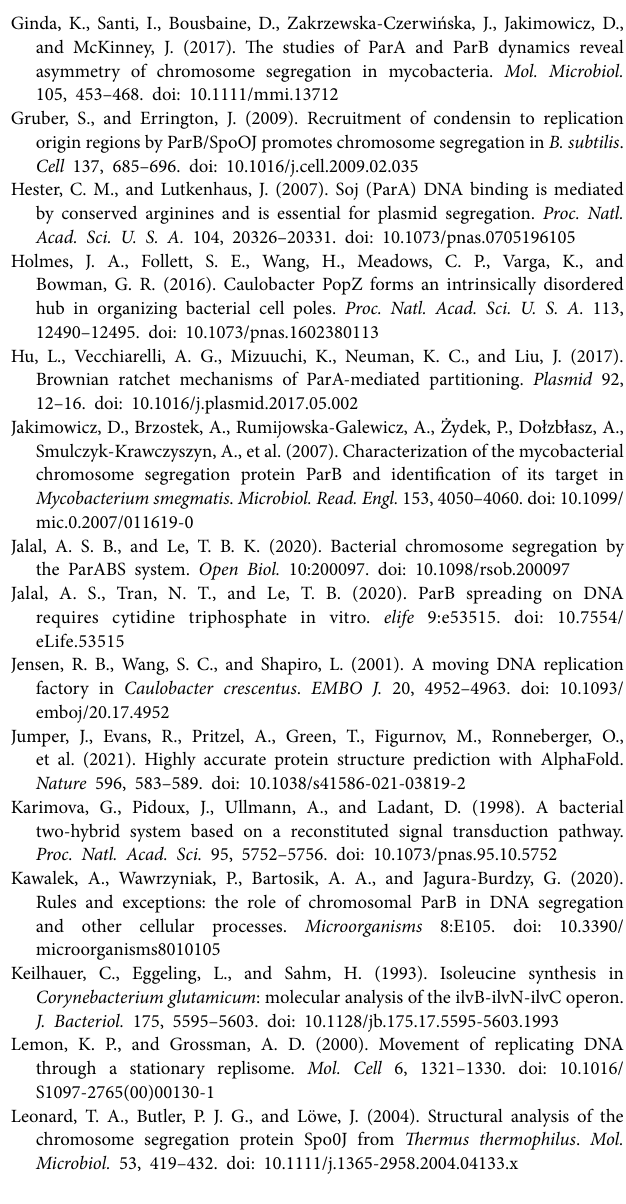
(ParACg) or heterologous parA from M. smegmatis (ParAMs), two clones of each strain were analysed. C. glutamicum Δ parA strain was used as the control ( Δ parA ). Cultures at logarithmic phase were induced with 0.05 mM IPTG for 2 h. Cells were lysed by sonication and 100 μ g of proteins were subjected to 10% SDS-PAGE electrophoresis and then transferred on nitrocellulose blotting membrane. The membrane was incubated with rabbit serum containing anti- ParA Ms antibody. As secondary antibody anti-rabbit IgG conjugated with alkaline phosphatase was used. Prestained protein ladder Thermo Scientific was used as a marker (marked as M). Supplementary Figure S4 | ParB complexes in Corynebacterium glutamicum parA mutant strains. C. glutamicum parA deletion strain complemented with native parA gene (ParA Cg ) and Mycobacterium smegmatis parA (ParA Ms ). Upper panel: microscopy images of examples of C. glutamicum cells producing ParB-YPet (yellow) with membranes stained with FM4-64 (red). Lower panel: percentage of cells possessing a specific number of ParB complexes. Scale bar: 1 μ